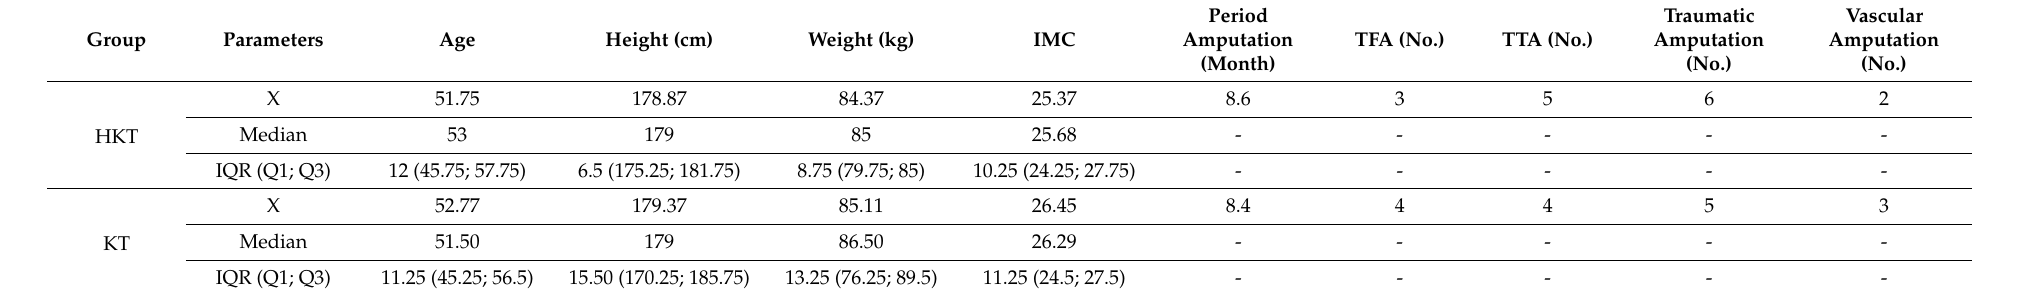
Table 1. Statistical analysis and distribution of characteristic of study